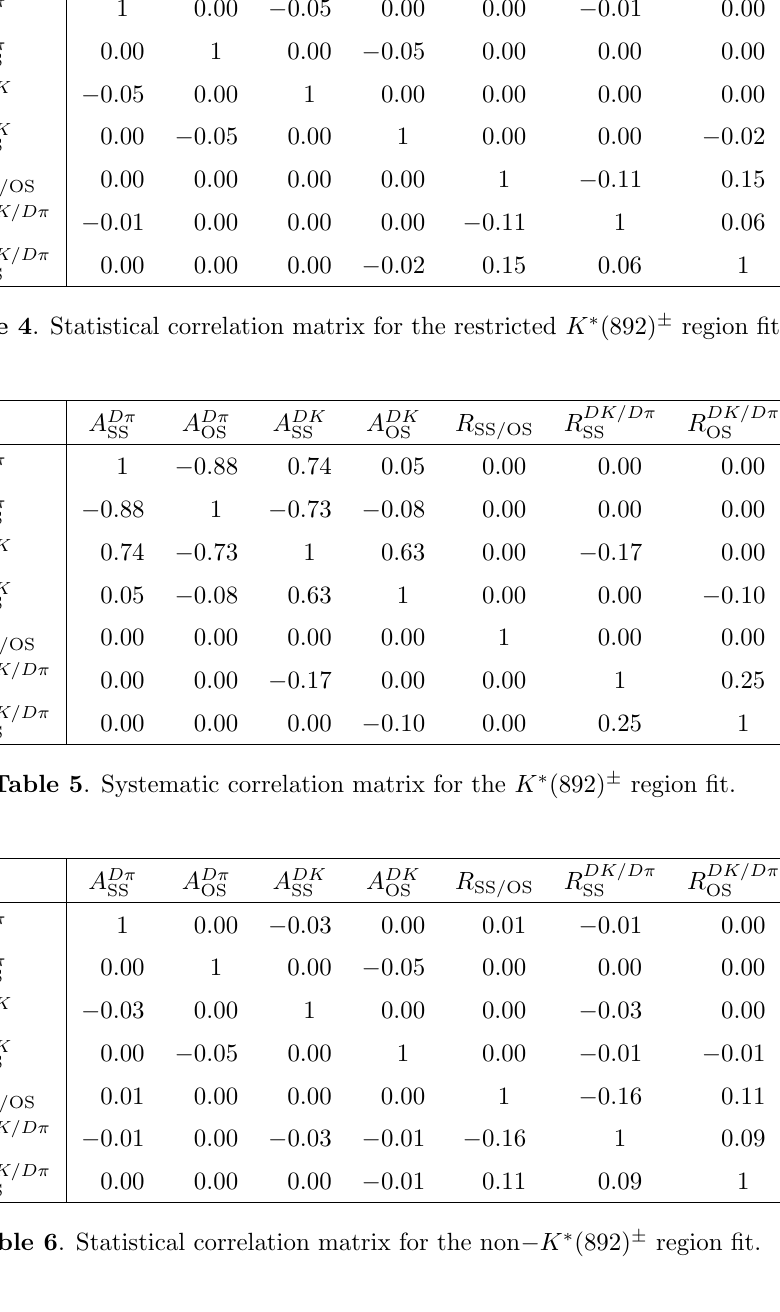
K (cid:3) (892) (cid:6) region (cid:0)